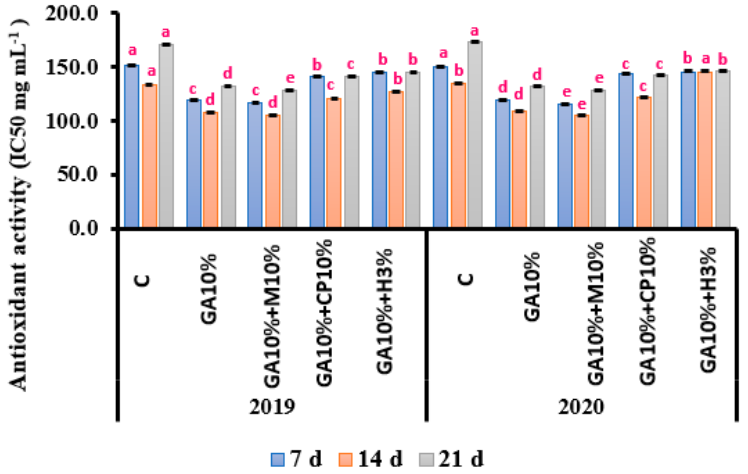
Figure 5. Effect of edible coatings—moringa extract, cactus pear, henna, and GA—on VC juice content, total phenols, carotenoid, and antioxidants activity (IC 50 mg 100 mg − 1 FW) of guava during cold storage for 21 days throughout two seasons (2019–2020). The superscript letters, present the significantly between effect of treatments using Duncan’s multiple range tests.